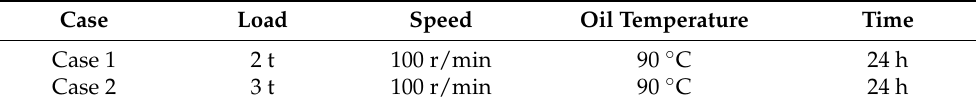
Table 1. Condition